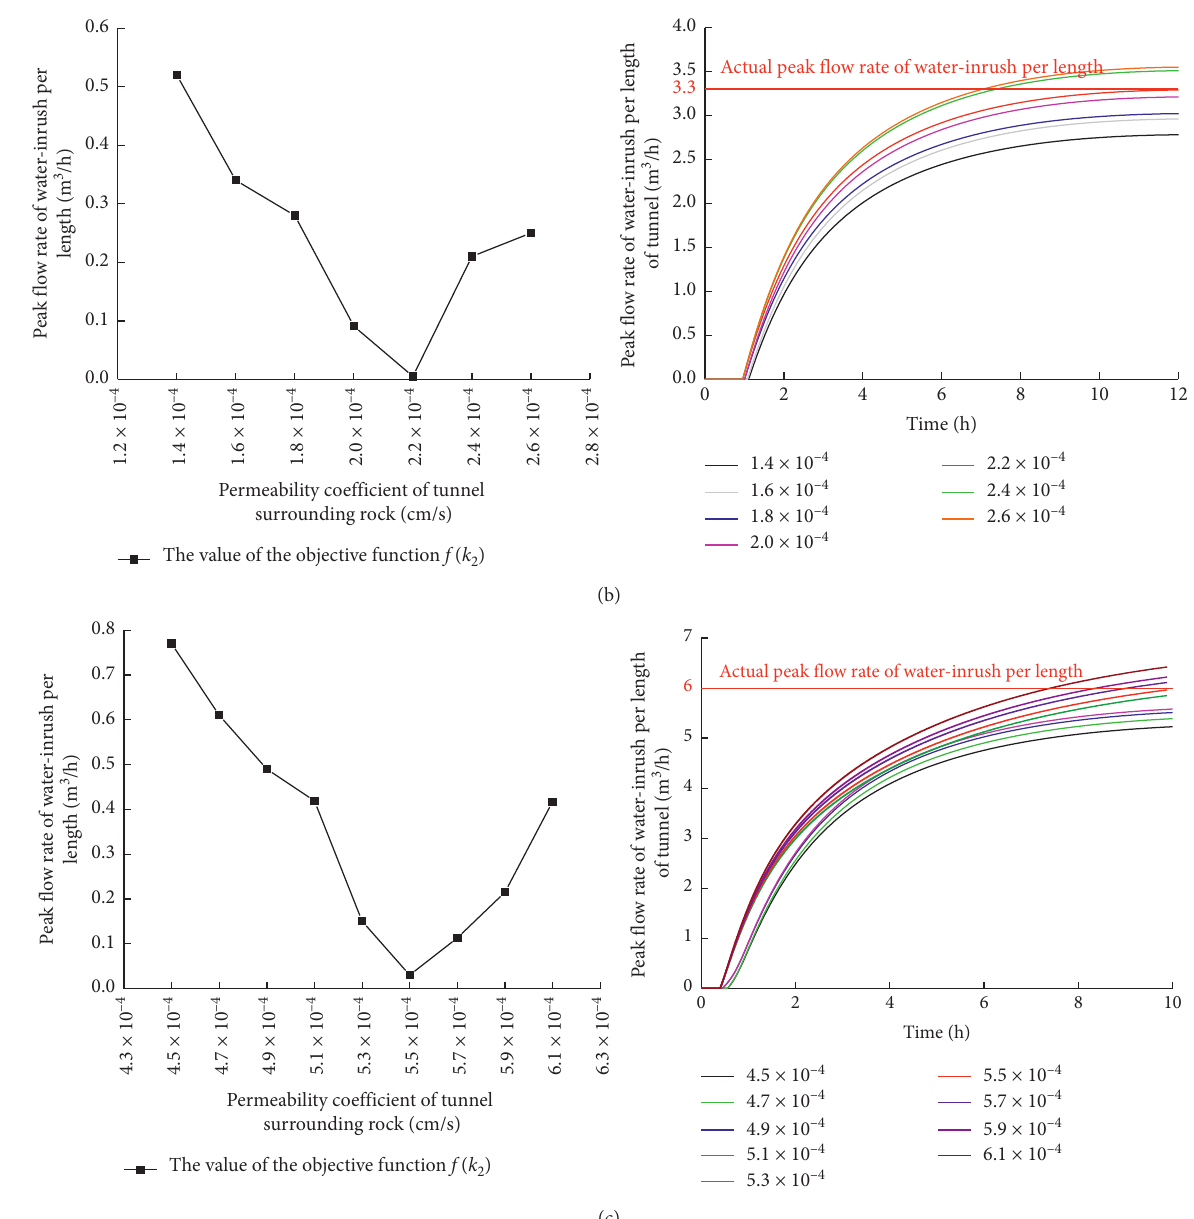
Figure 12: Relationship between objective function and the permeability coefficient of the tunnel surrounding rock: (a) No. 1 water-inrush incident; (b) No. 2 water-inrush incident; (c) No. 3 water-inrush